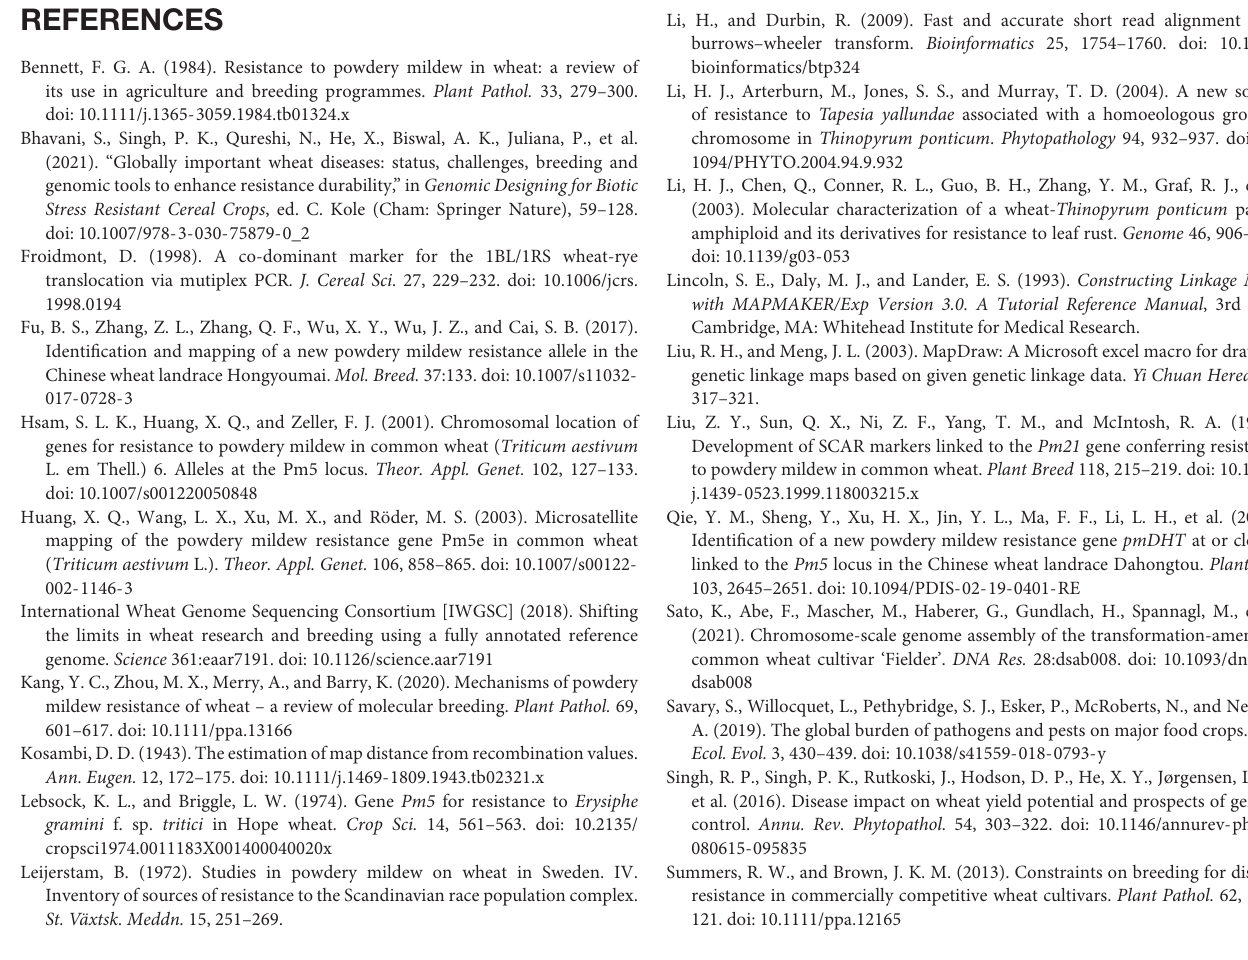
Supplementary Figure 1 | Detection of Th. ponticum gene using primer 2P1 and 2P2. M: 100 bp DNA ladder; 1: Xiaoyan 693; 2: H962R; 3: H962S. Supplementary Figure 2 | Detection of Th. ponticum gene using primer ω -sec-P1 and ω -sec-P2. M: 100 bp DNA ladder; 1: H962R; 2: H962S; 3 and 4: Secale cereale ; 5: 1R-2; 6: